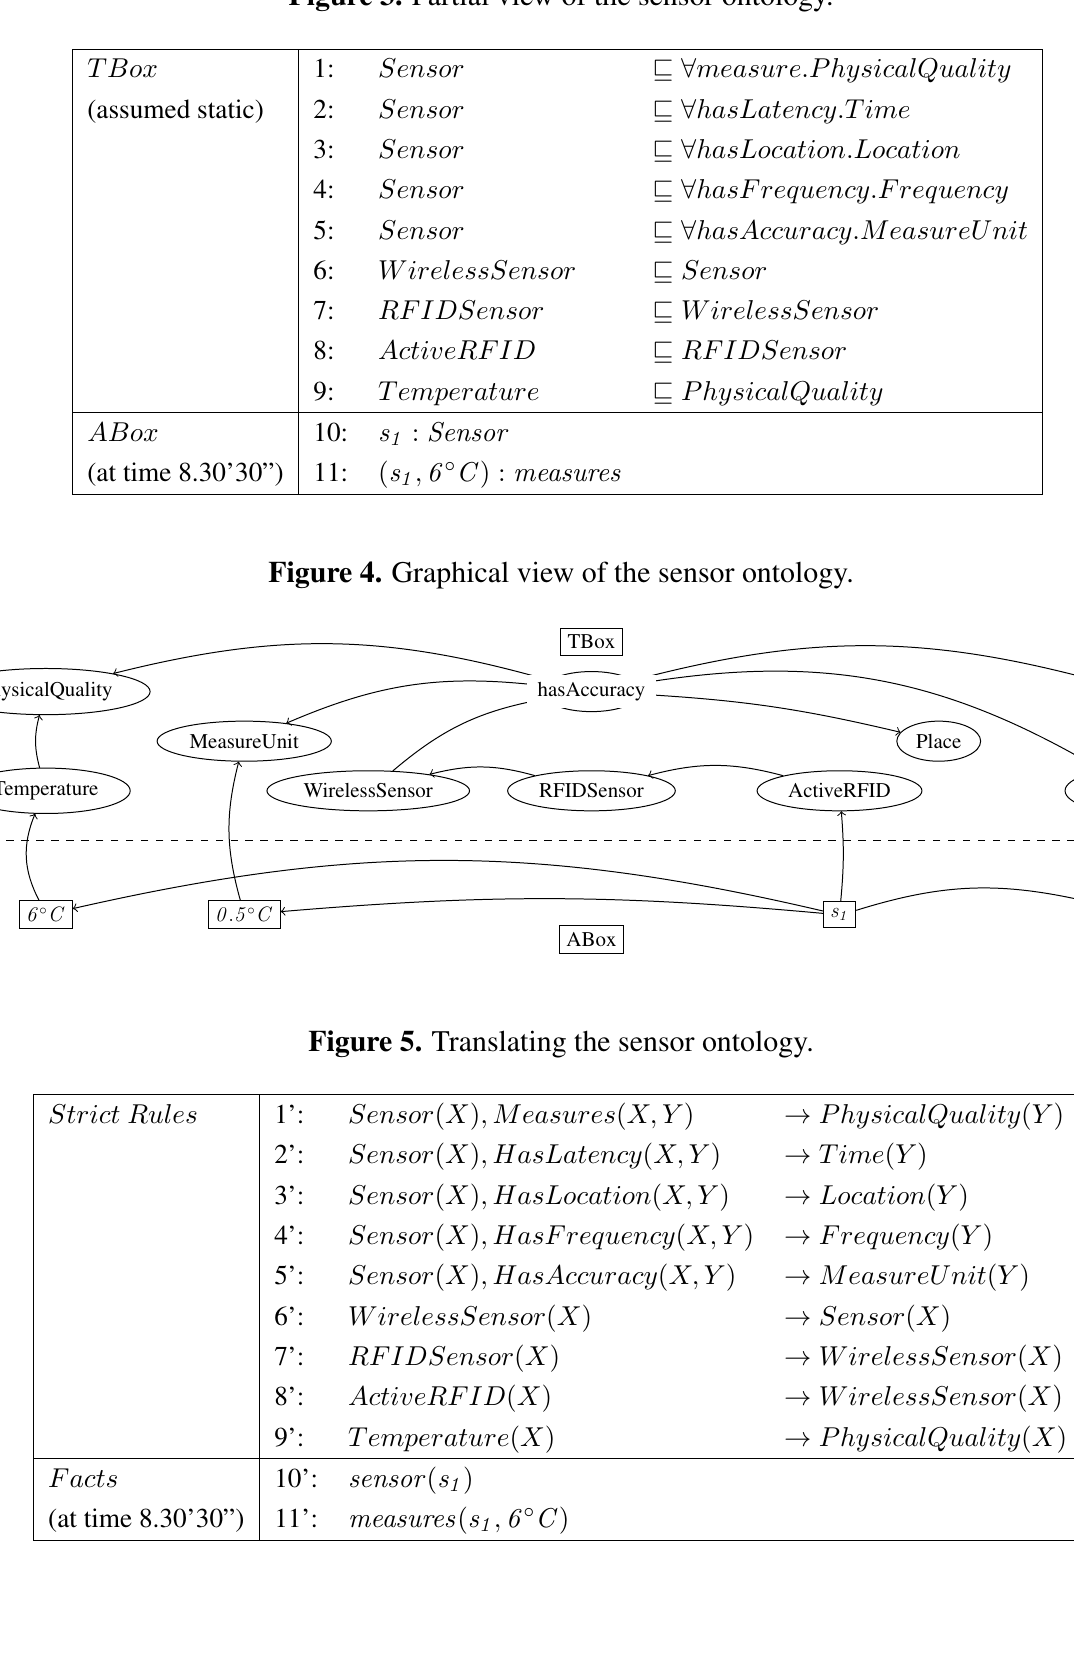
Figure 3. Partial view of the sensor ontology.